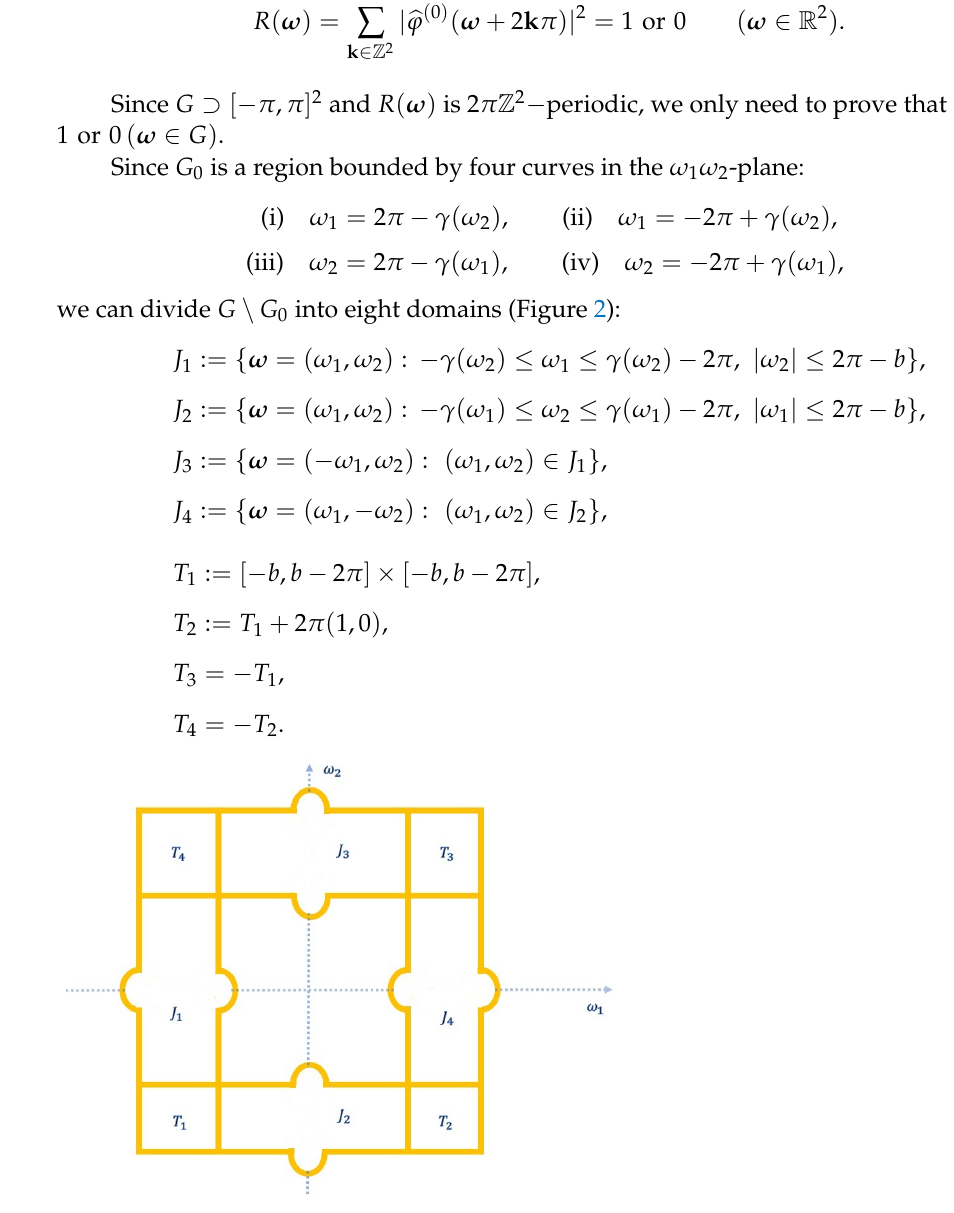
Figure 2. Divide G \ G 0 into eight domains: J 1 , J 2 , J 3 , J 4 and T 1 , T 2 , T 3 , T 4